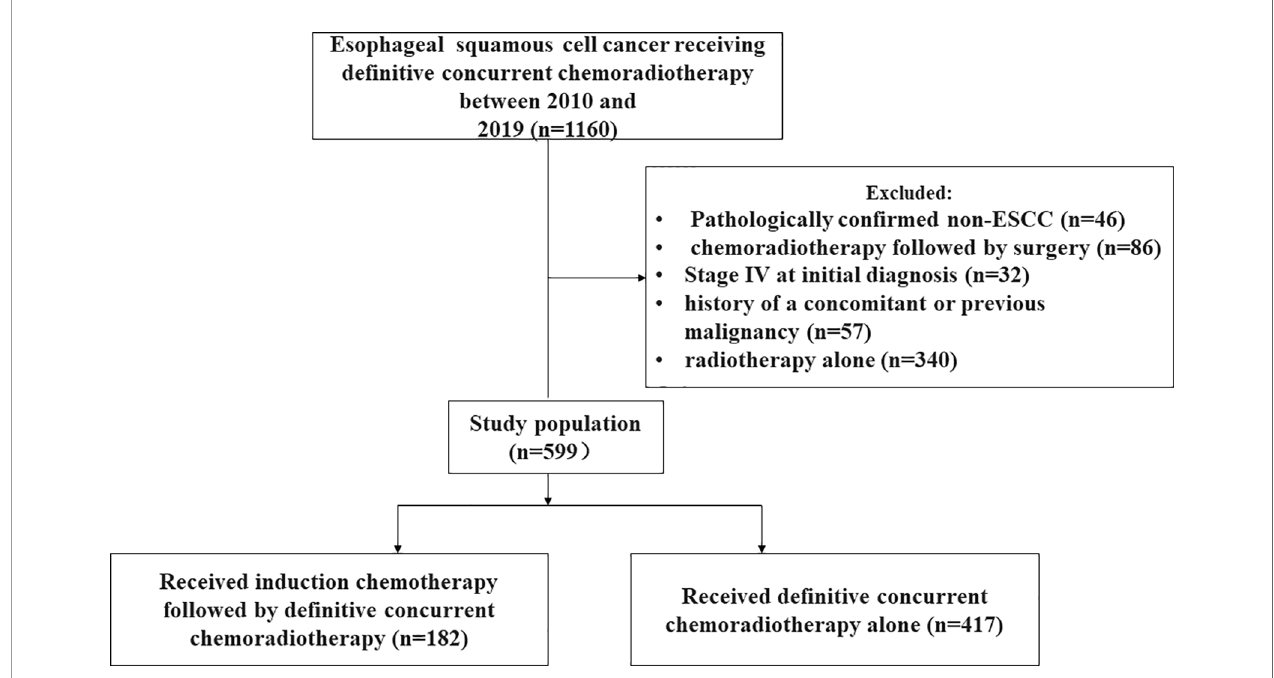
FIGURE 1 | The fl owchart of the screening